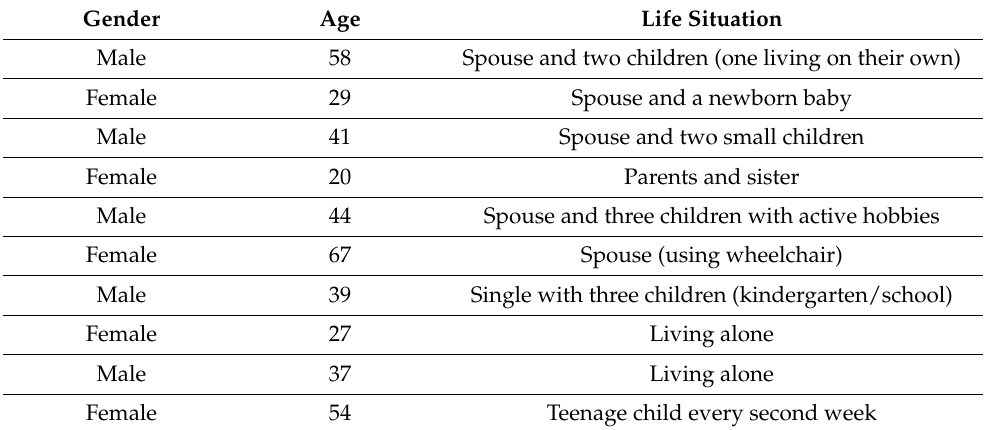
Table 2. Demographic information about the final research participants.